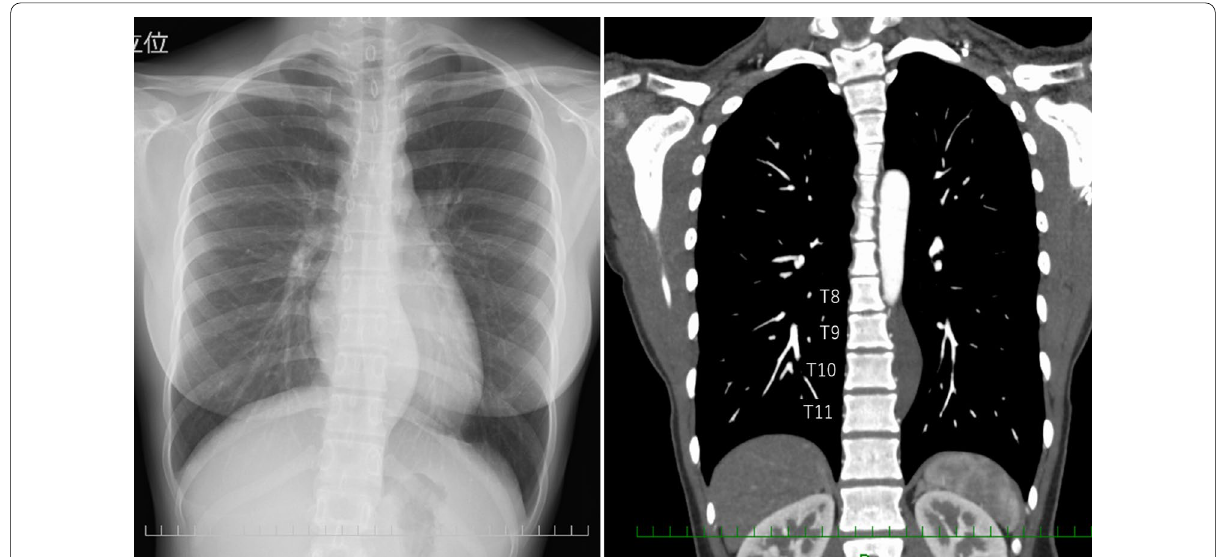
Fig. 1 Chest roentgenogram (left) and computed tomography (right) showed a large paravertebral mass. T8, 8th thoracic vertebra; T9, 9th thoracic vertebra; T10, 10th thoracic vertebra; T11, 11th thoracic